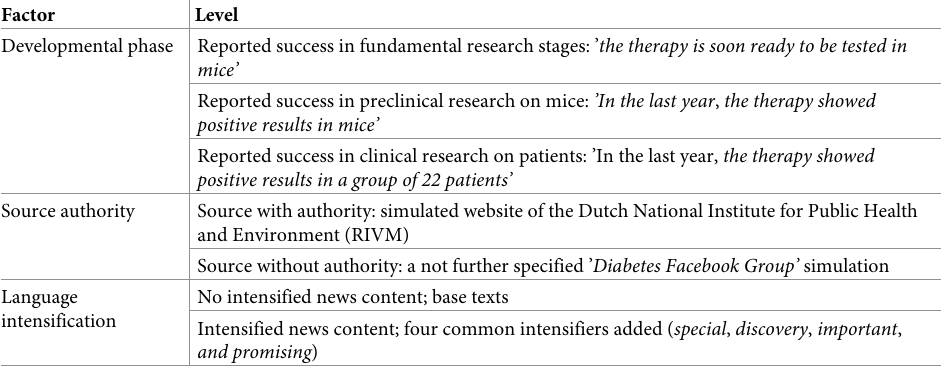
Table 1. Factors and levels used in the construction of the